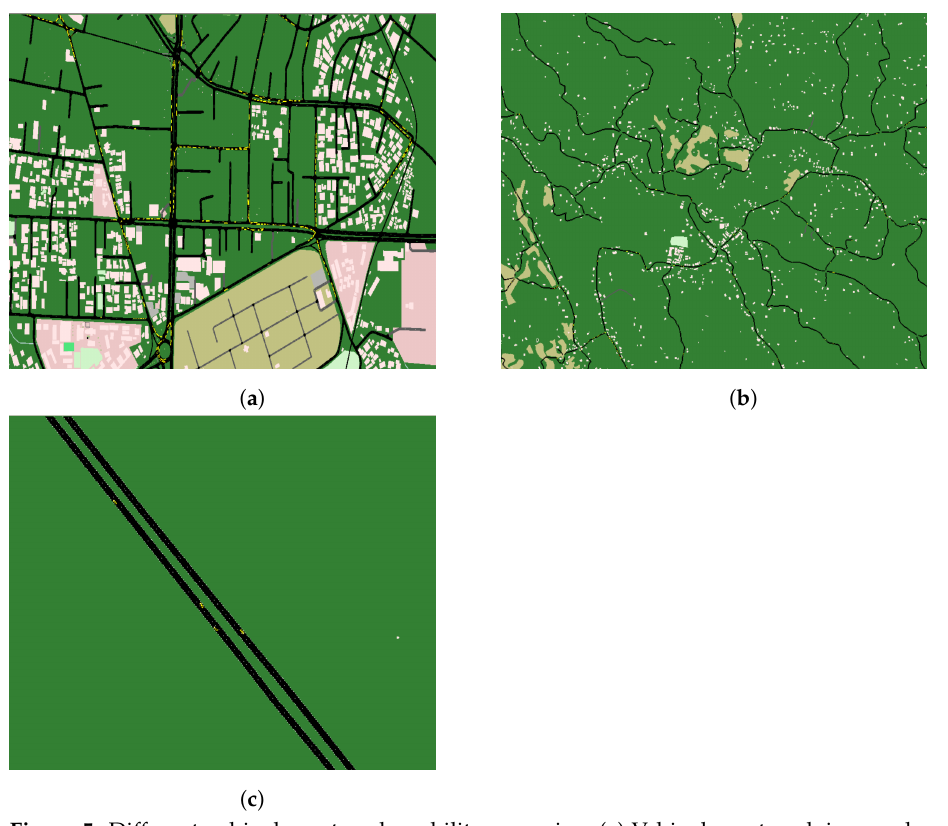
Figure 5. Different vehicular network mobility scenarios. ( a ) Vehicular network in an urban area in Colombo; ( b ) Vehicular network in a non-urban area in Neluwa; ( c ) Vehicular network on the southern expressway in